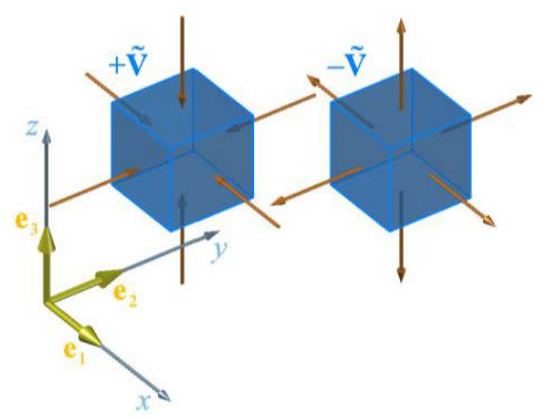
Figure 29: How the positive outer orientation depends on the di- mension n of the embedding space.